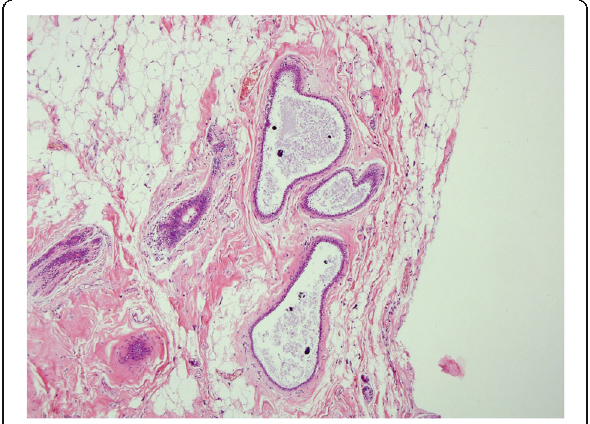
Fig. 1 Columnar cell change showing dilated acini covered by cells with prominent apical